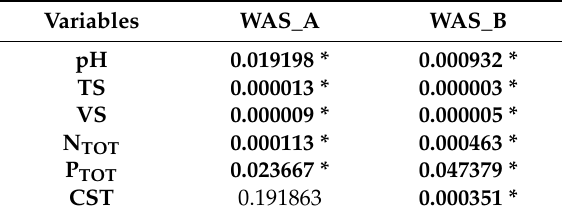
Table A4. The results of T -Test—technological